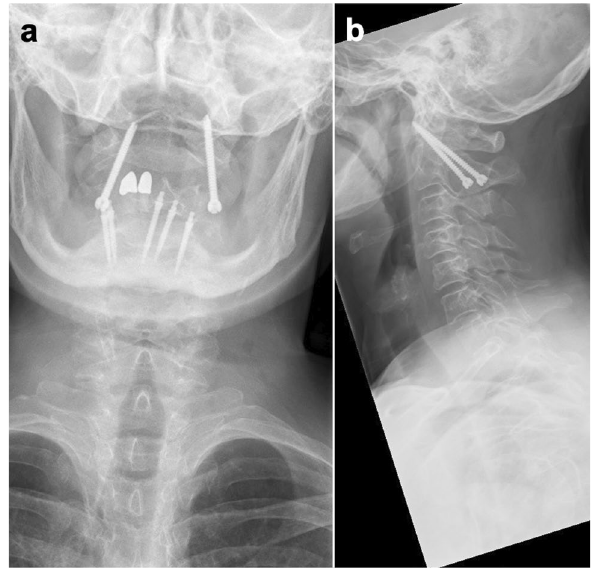
Figure 2. Incorrect screw position. This figure shows the malpositioning of a screw that occurred in the current study . Conventional X-ray. ( a ) Anterioposterior plane. The right-sided screw misses the articular surface of C1 on the medial side. No bridging of the joint occurs and the screw does not find a position in the right lateral mass of C1. ( b ) Sagittal plane. In this plane, the screw position appears largely